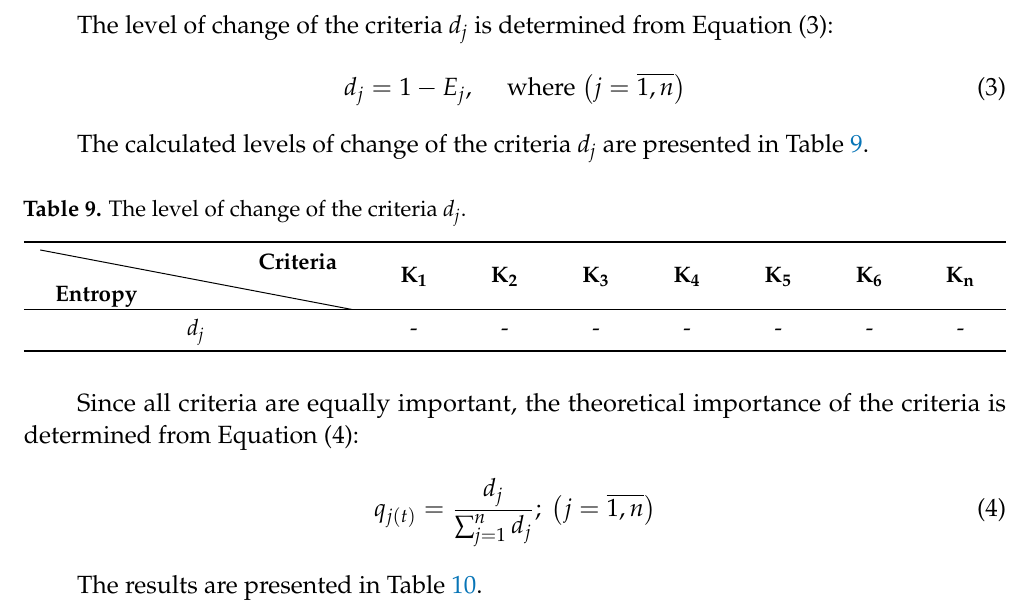
Table 10. The theoretical importance of the criteria. Criteria Entropy